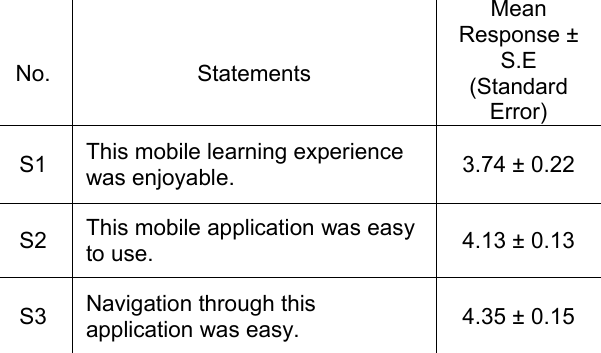
Table 2. Responses related to the mobile learning aspect.